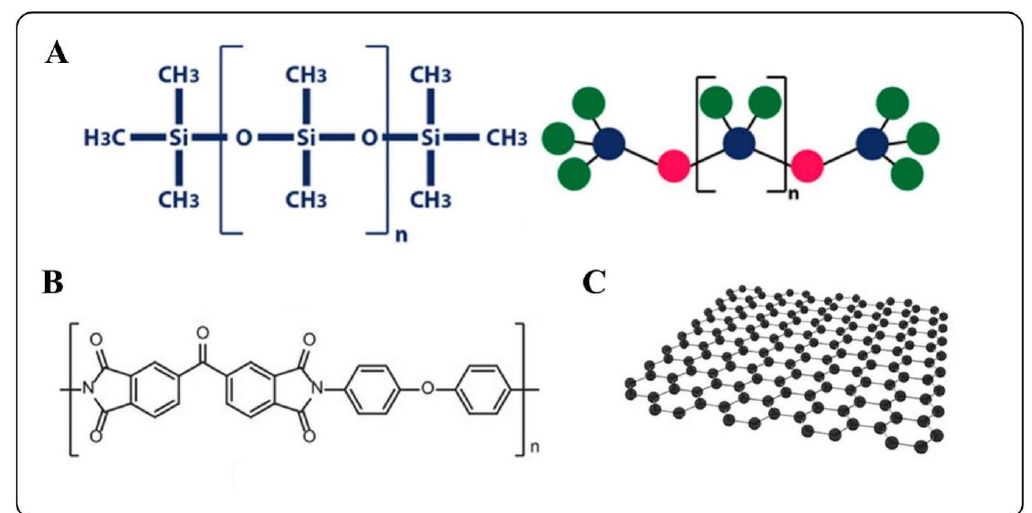
Figure 7. Chemical structure diagram of ( A ) PDMS, reprinted with permission from ref. [137]. Copyright 2021, MDPI, ( B ) PI, reprinted with permission from ref. [114]. Copyright 2019, Wiley, ( C ) graphene, reprinted with permission from ref. [138]. Copyright 2022, Wiley.